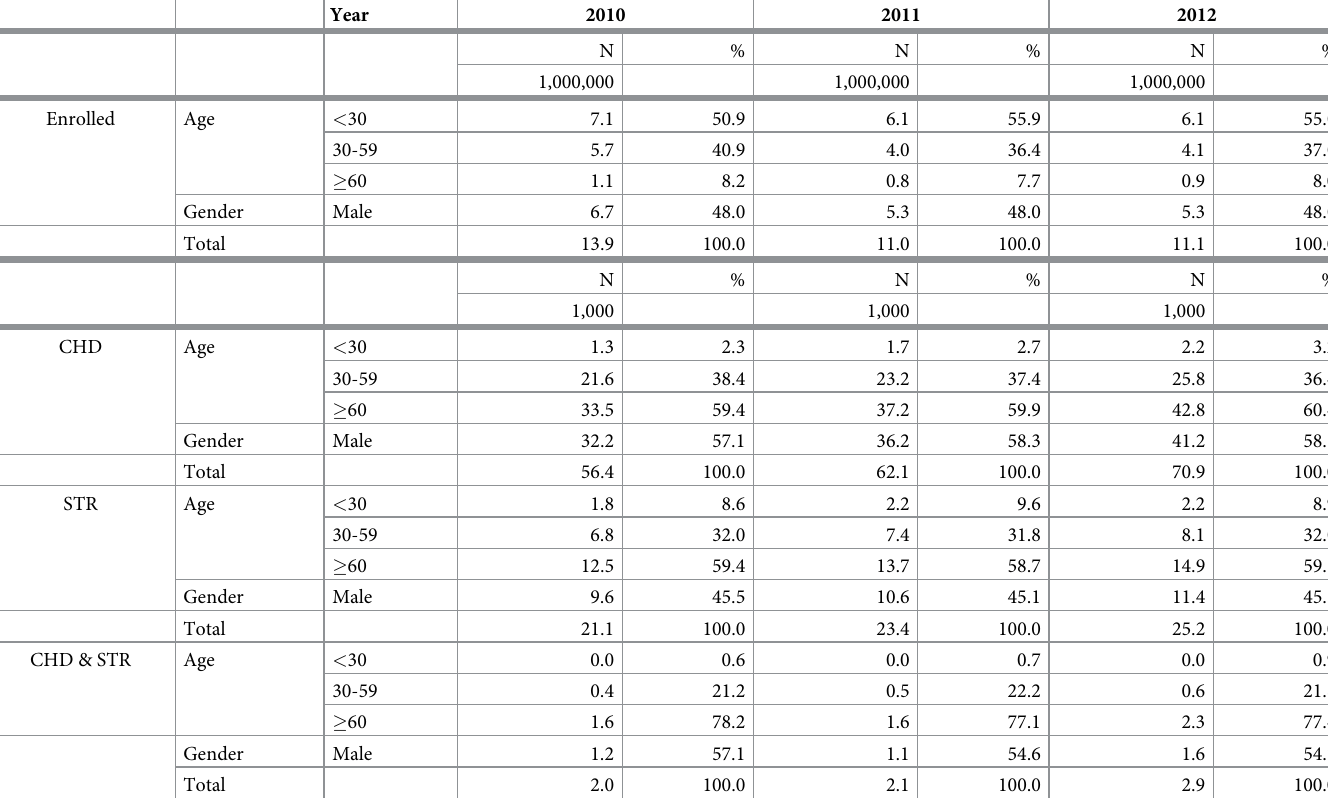
Table 2. Population and number of individuals with CVD